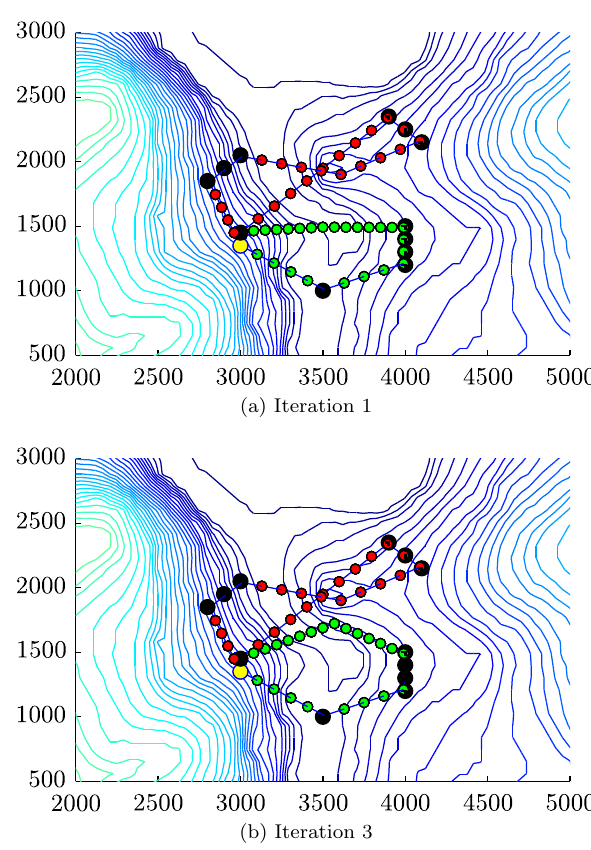
Figure 13: Scenario 2: Top view of the planned path at (a) 1st iteration, and (b) 3rd and final iteration. See also caption text for Figure 7.